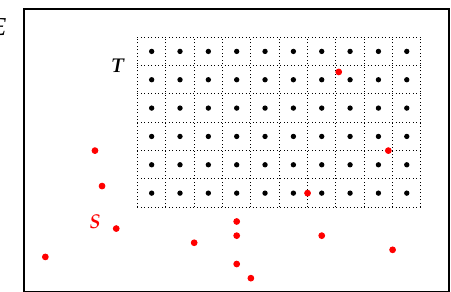
Figure 6. Source ( • ) and target ( • ) events. The target events are the centers of a regular lattice of equal cells arranged as an ( n + 1 ) -dimensional